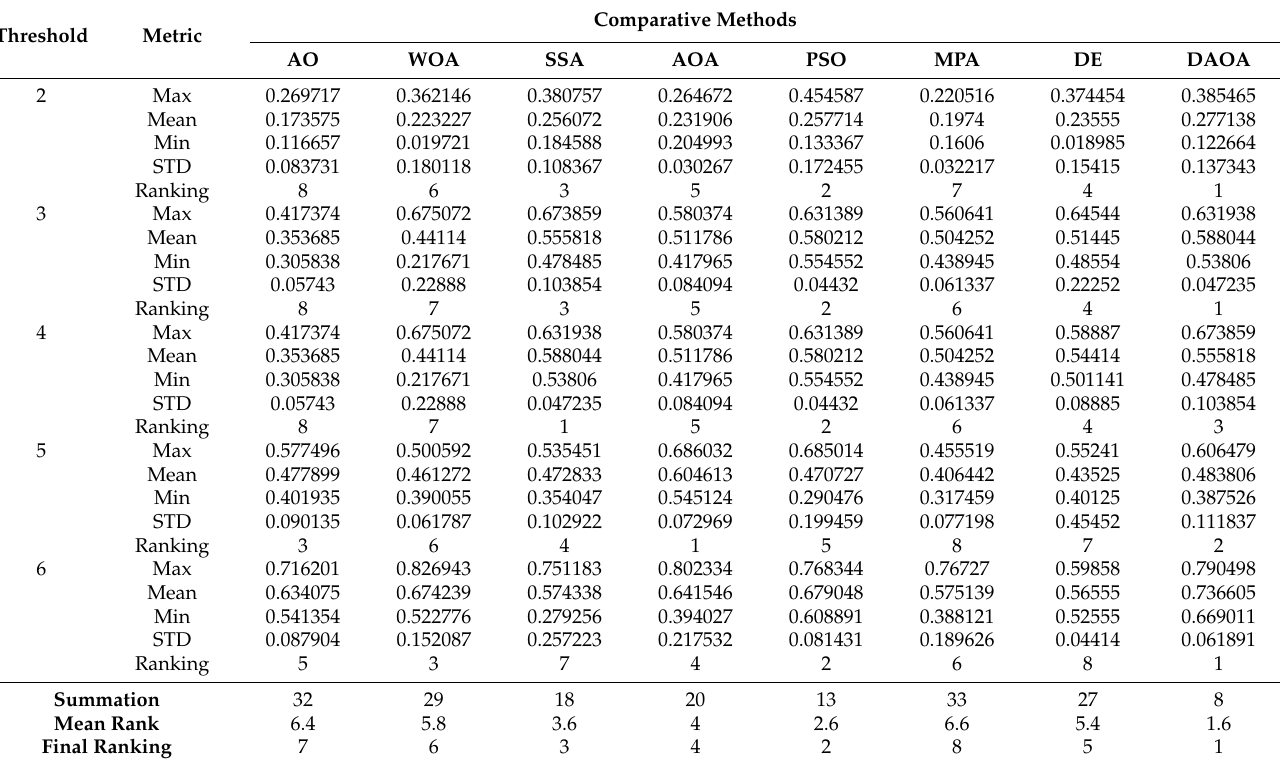
Table 3. The SSIM results of the test case